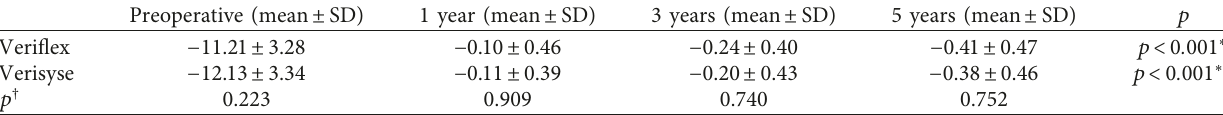
Table 3: Refractive Sphere during